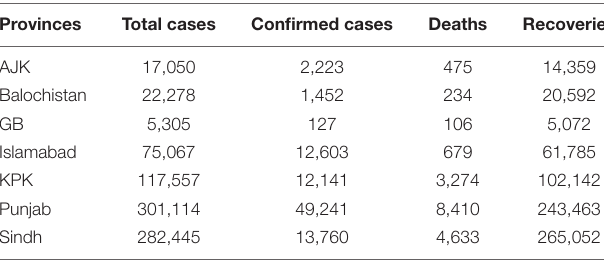
TABLE 1 | COVID-19 cases in Pakistan (April 30,